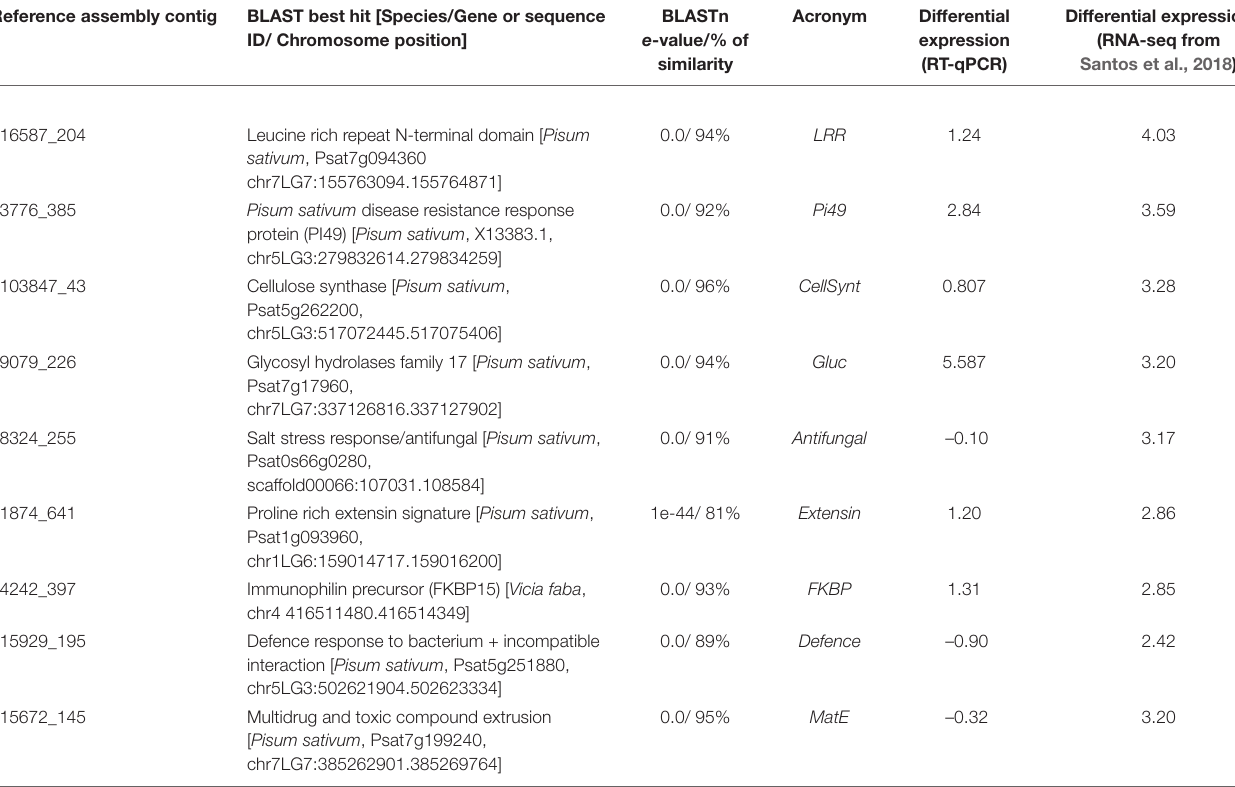
TABLE 2 | Genes related to rust resistance, selected from previously identified in a leaf-transcriptomic RNAseq study between BGE023542 (partially resistant) and BGE008277 (susceptible) Lathyrus cicera RIL parental lines in response to Uromyces pisi infection (Santos et al., 2018). Reference assembly